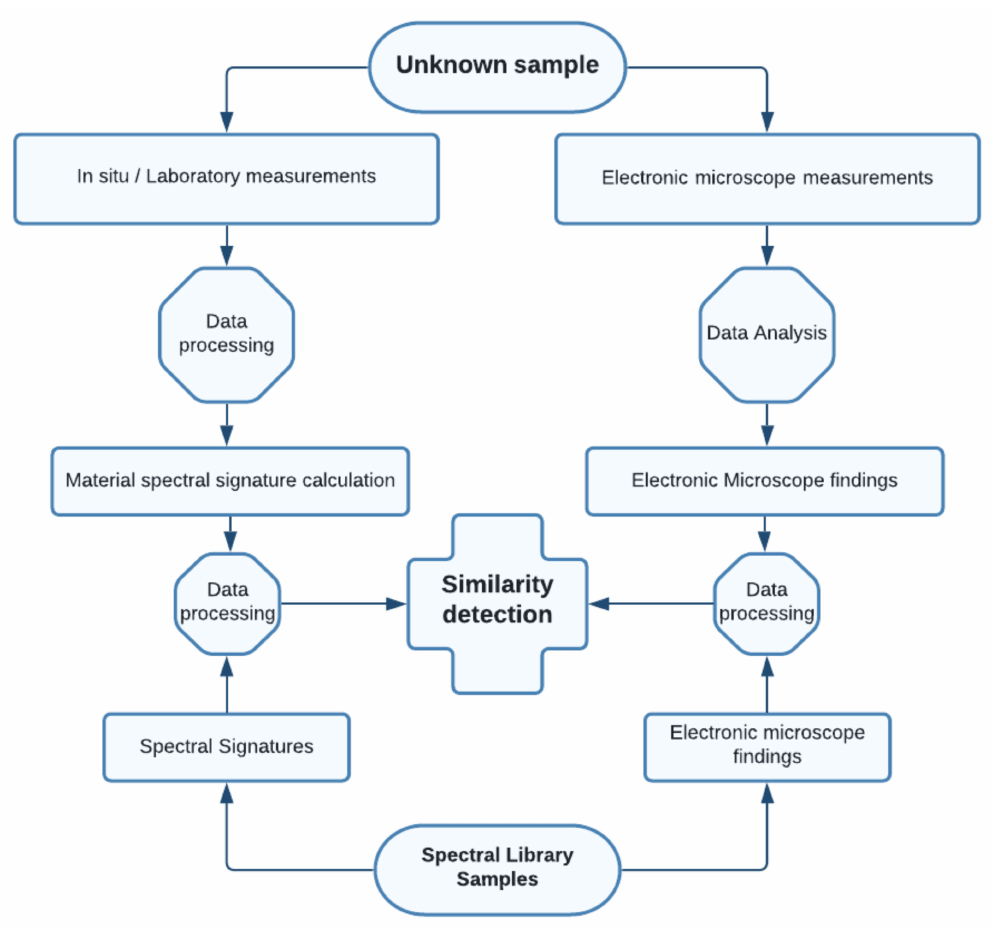
Figure 15. Determination of unknown sample—processing